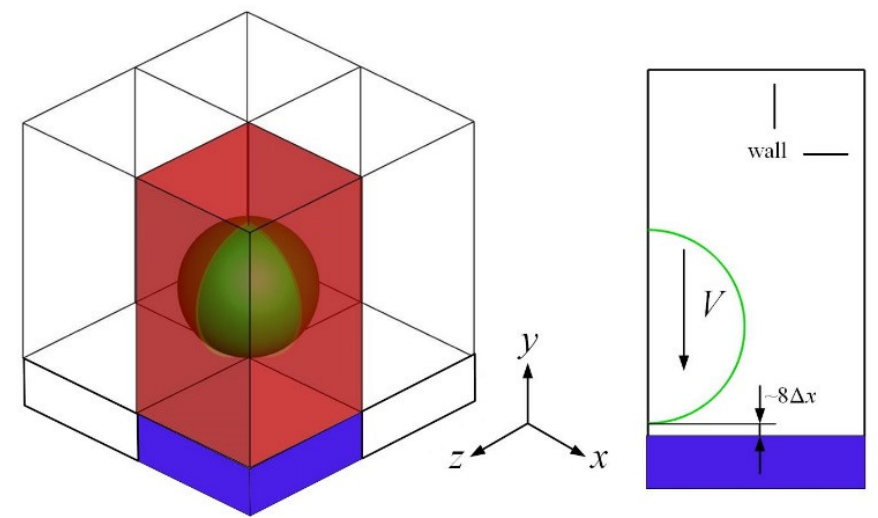
Figure 1. Schematic of the problem, with the blue denoting substrate. Thermal contact resistance is taken into account, with a large value between the gas and the substrate and with a small one between the drop and the substrate. Initially, the drop is sitting ~8 ∆ x , or 3.2 µ m, above the substrate, with an impacting velocity ranging from subsonic to supersonic. The substrate is preheated to 423 K [21], and the drop and surrounding gas are at the same temperature at the